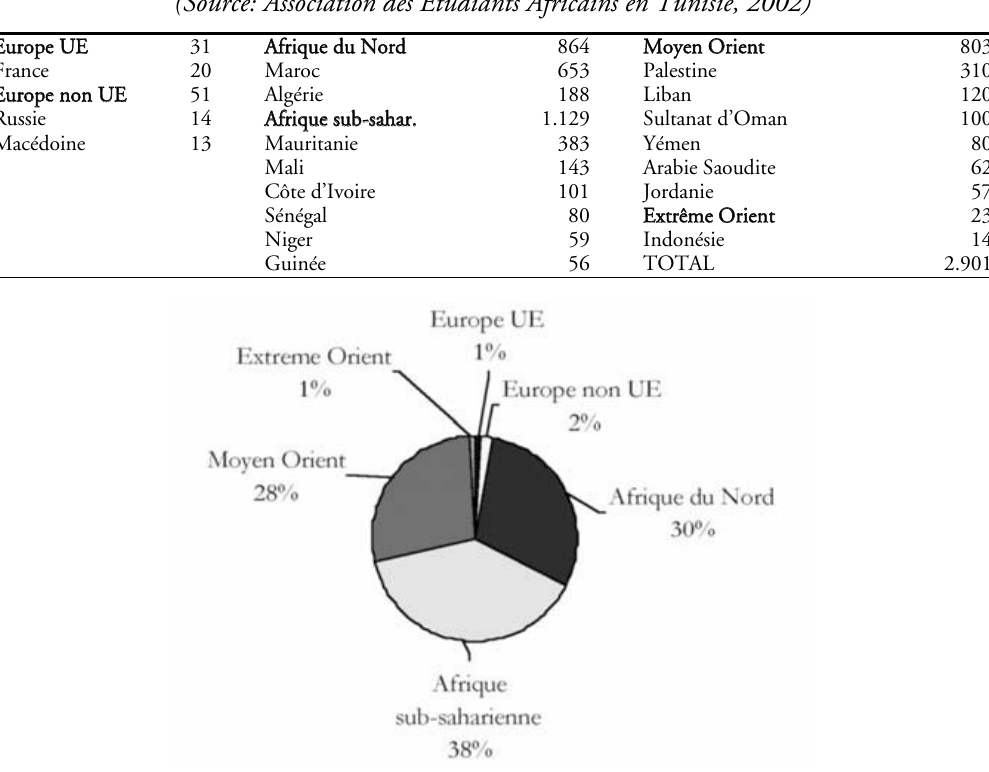
Figure 2 – Etudiants universitaires étrangers en Tunisie (en pourcentage), année universitaire 2001/2002 (Source: Association des Etudiants Africains en Tunisie, 2002)